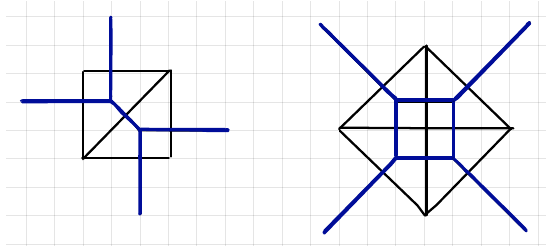
Figure 4. The conifold and its Z 2 -quotient and their dual diagrams in